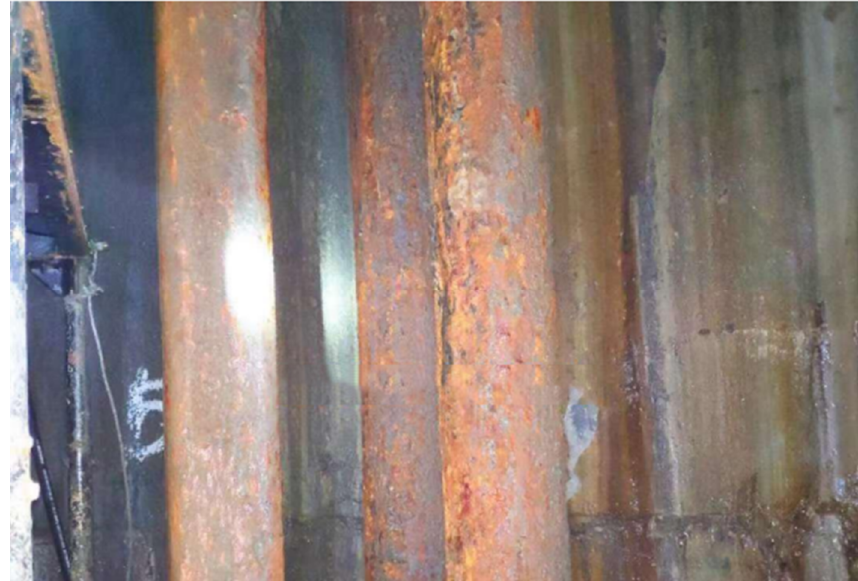
Figure 1. Shaft equipment corroded by ore water.